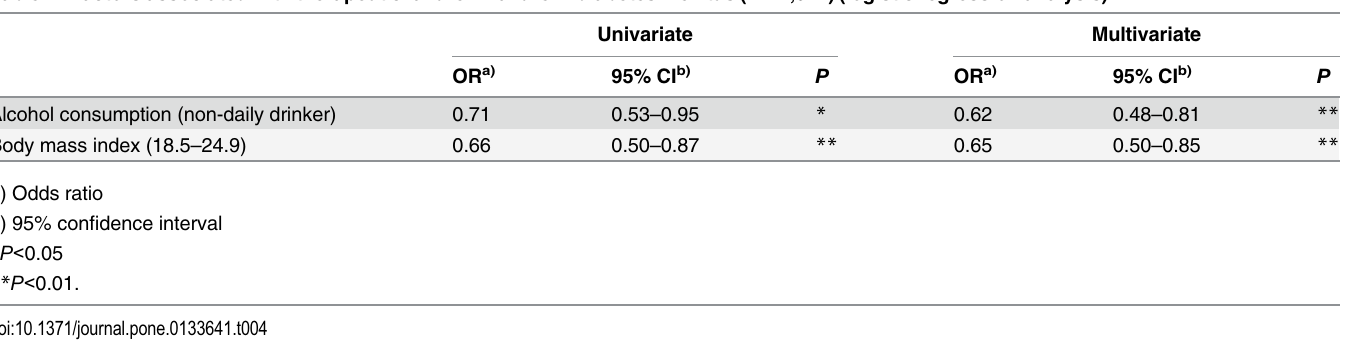
Table 4. Factors associated with therapeutic failure in failure in diabetes mellitus (n = 1,074) (logistic regression analysis).